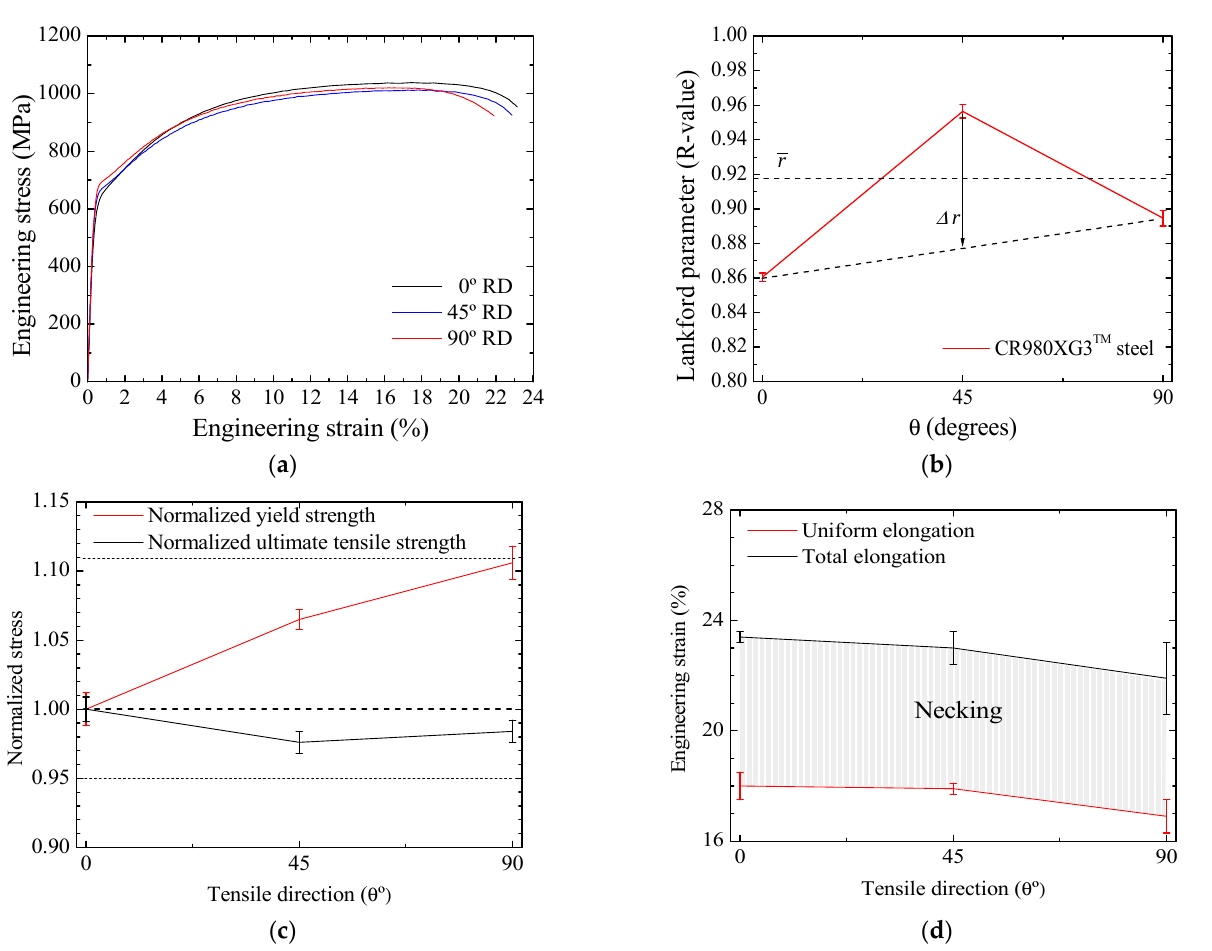
Figure 9. Uniaxial tensile test results of the CR980XG3 TM steel sheet: ( a ) engineering stress–strain curves at 0°, 45°, and 90°, and angular evolutions of the ( b ) Lankford r -values, ( c ) normalized yield stress and ultimate tensile strength, and ( d ) uniform and total elongation.